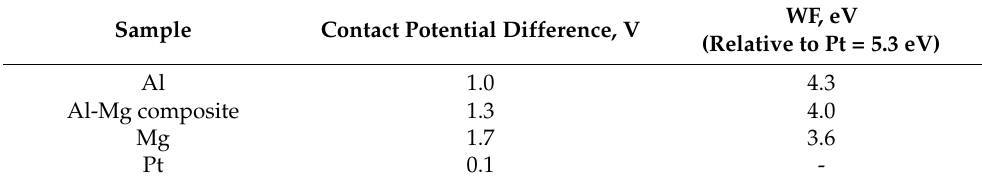
Table 2. Contact potential difference and WF of Al, Mg and Al-Mg composites measured in relation to the WF of Pt, considered to be equal to 5.3 eV [18], using the Kelvin–Zisman method (vibrating electrode